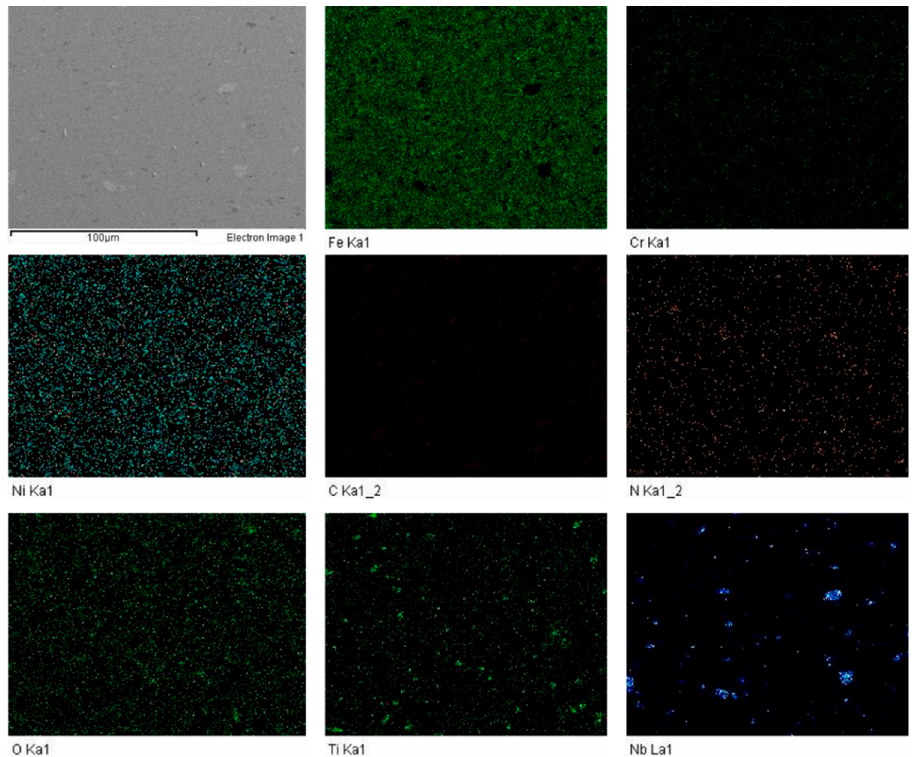
Figure 6. FESEM-EDS elemental mapping for sample S3.